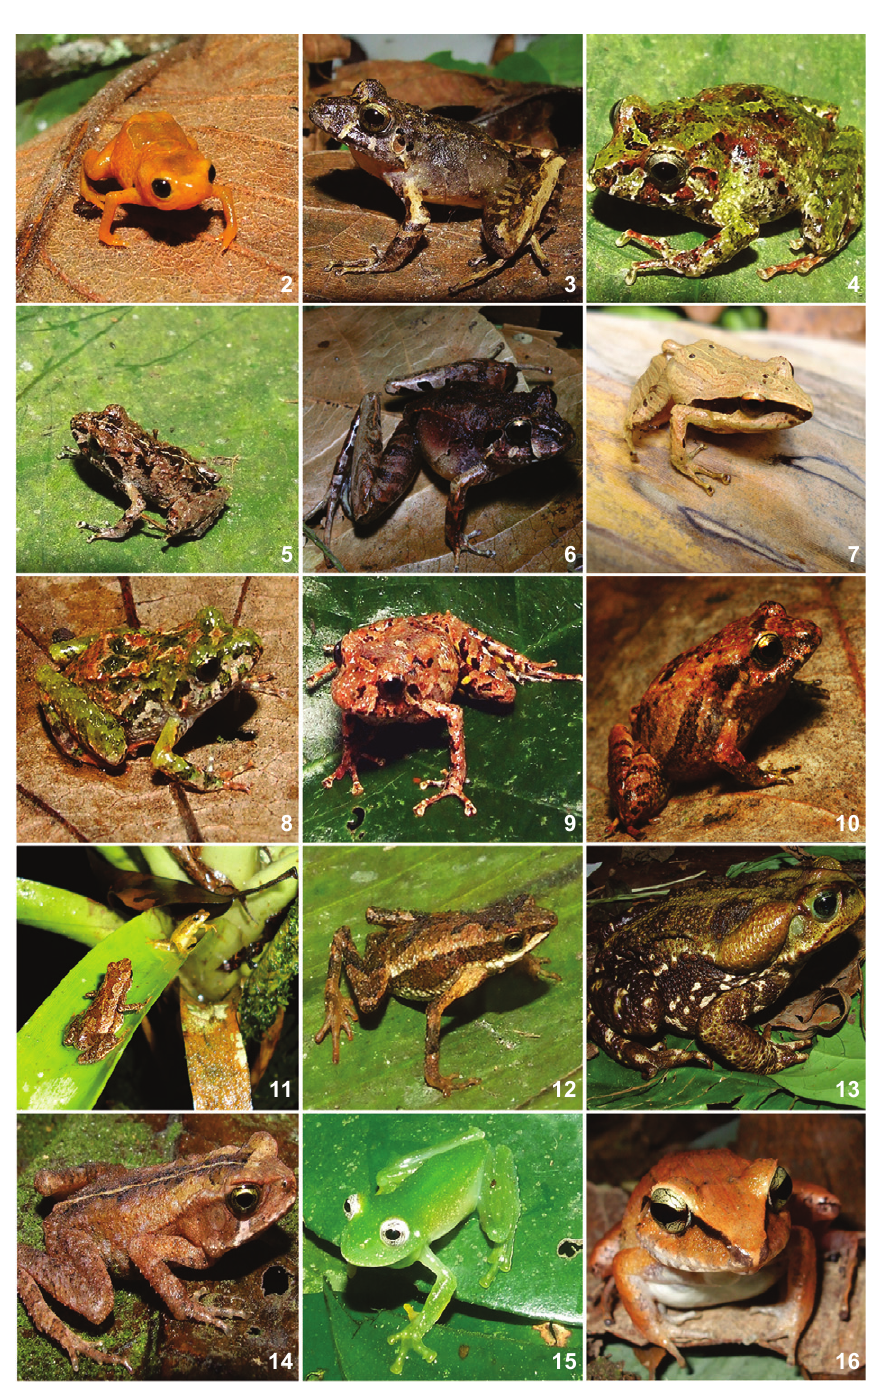
Figures 2-16. Anuran species sampled for the Parque Natural Municipal Nascentes de Paranapiacaba, Santo André, São Paulo state: (2) Brachycephalus sp.; (3) Ischnocnema sp. (aff . guentheri ); (4) Ischnocnema sp. ( lactea series); (5) Ischnocnema cf. spanios ; (6) Ischnocnema guentheri ; (7) Ischnocnema hoehnei ; (8) Ischnocnema juipoca ; (9) Ischnocnema nigriventris (10) Ischnocnema parva ; (11) Dendrophryniscus brevipollicatus ; (12) Dendrophryniscus cf. brevipollicatus ; (13) Rhinella icterica ; (14) Rhinella ornata ; (15) Vitreorana uranoscopa ; (16) Haddadus binotatus ; (17) Cycloramphus dubius (ZUEC 6859). Photos: Vivian C. Trevine, except: 6, 10 (Juan Camilo